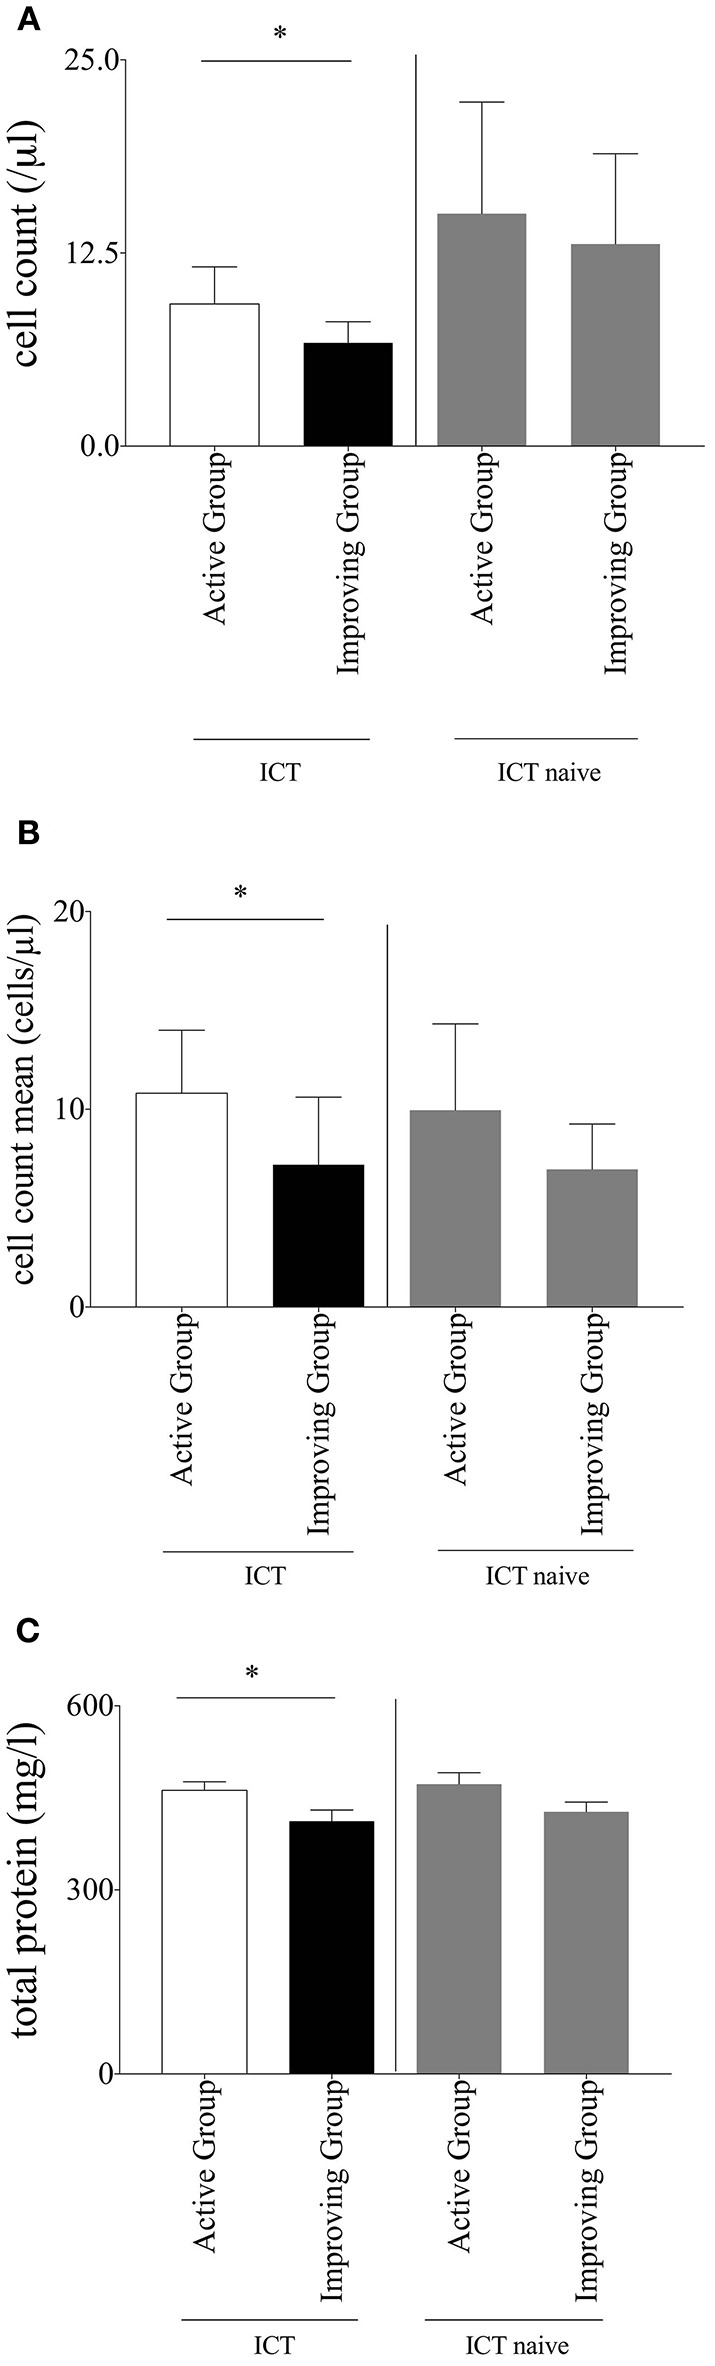
(A) Cell count. Baseline cerebrospinal fluid parameter cell count of multiple sclerosis patients within intrathecal corticosteroid therapy (ICT) compared between the subgroups; separate comparison of multiple sclerosis patients without ICT between the two subgroups; Mann–Whitney-U-test, mean with SEM, n (improving group ICT) = 172, n (active group ICT) = 310, n (improving group ICT naïve) = 88, n (active group ICT naïve) = 137; *p = 0.0442. (B) Cell count mean. Mean of cerebrospinal fluid parameter cell count of multiple sclerosis patients within ICT compared between the subgroups; separate comparison of multiple sclerosis patients without ICT between the two subgroups; Mann–Whitney-U-test, mean with SEM, n (improving group ICT) = 76, n (active group ICT) = 59, n (improving group ICT naïve) = 46, n (active group ICT naïve) = 47; *p = 0.0221. (C) Total protein. Baseline cerebrospinal fluid parameter total protein of multiple sclerosis patients within ICT compared between the subgroups; separate comparison of multiple sclerosis patients without ICT between the two subgroups; Mann-Whitney-U-test, mean with SEM; n (improving group ICT) = 155, n (active group ICT) = 282, n (improving group ICT naïve) = 88, n (active group ICT naïve) = 137; *p = 0.0014.